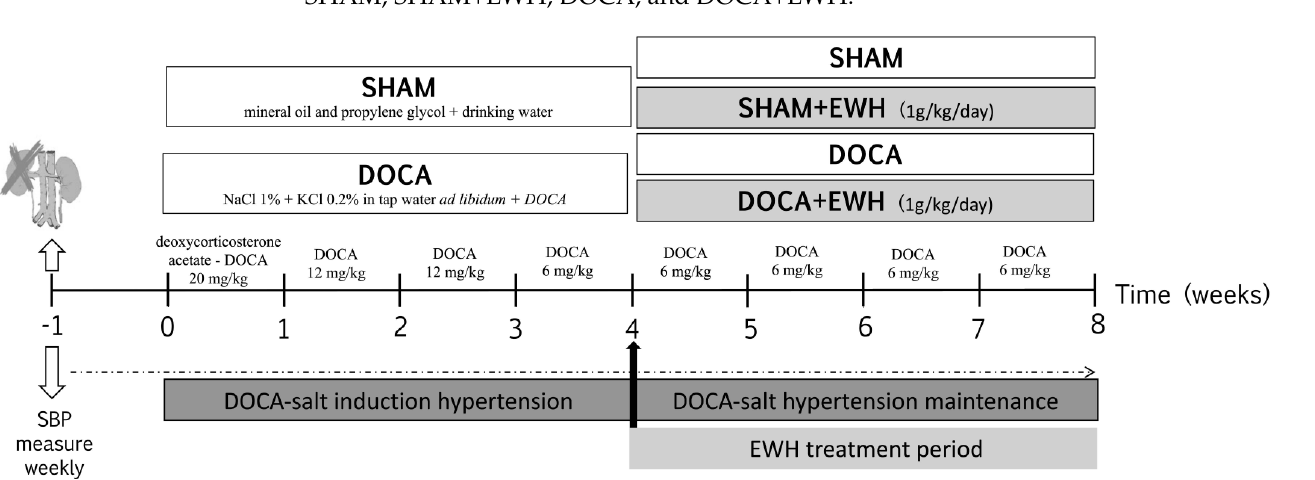
Figure 1. Schematic representation of experimental groups, DOCA-salt hypertension induction model and EWH treatment period.